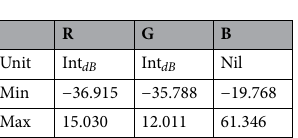
0 values in different bands.